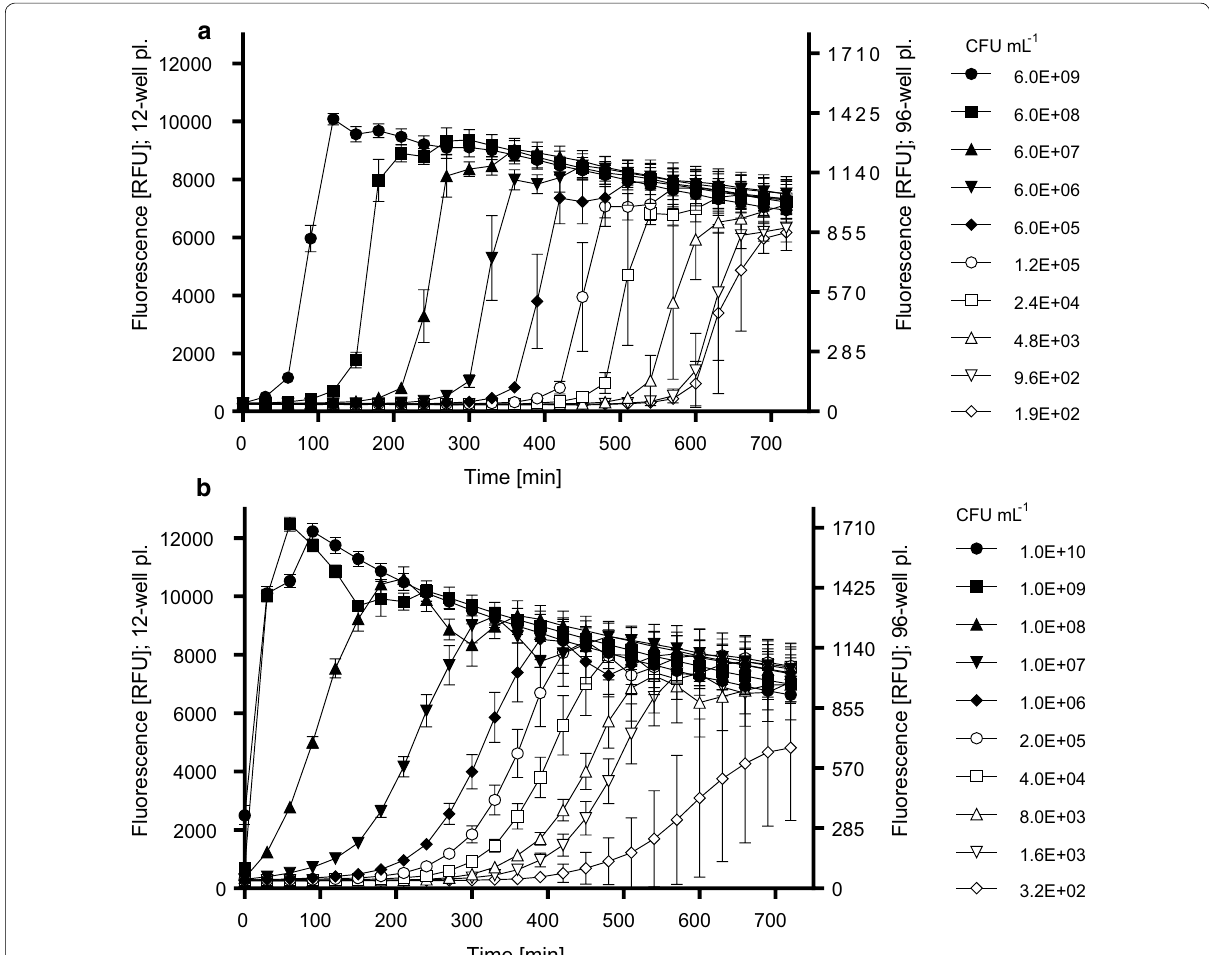
Fig. 2 Kinetics of resazurin metabolization in bacterial suspensions of E. coli ( a ) and E. faecalis ( b ) having various bacterial concentrations. Values represent the mean SD of hexaplicate determinations. The figure shows a set of results of one experimental run as an example of three analogous ± independent experiments for both bacterial